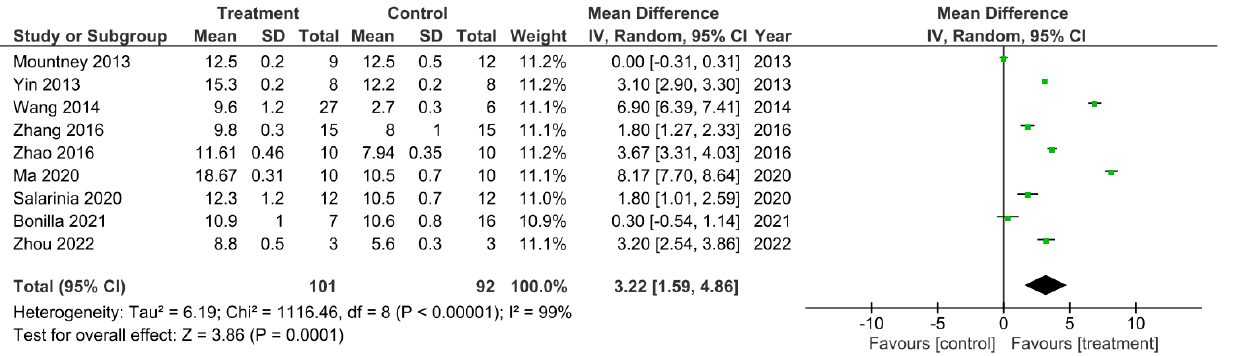
Figure 6. A meta-analysis for the effect of combined treatments on the improvement of BBB scores analyzed at the final recorded timepoints after spinal cord injury in nine studies [15,17,22,26–28,40,47,50].